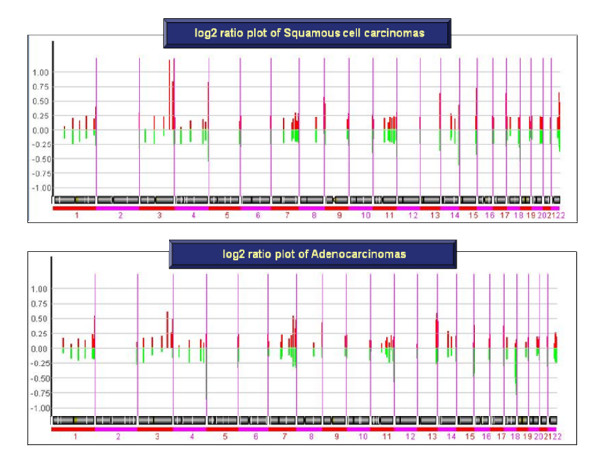
Signal intensity ratios for each spotted BAC clones of SCCs and ACs displayed as log2 plots. A total of 4,046 BAC clones were ordered (x-axis) according to the map positions and the chromosomal order from 1pter to 22qter.